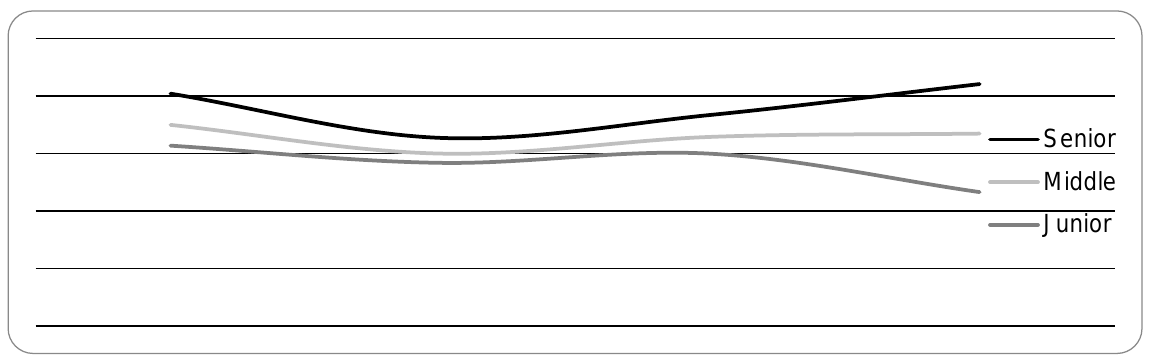
Fig 3: difference in position about leadership skills